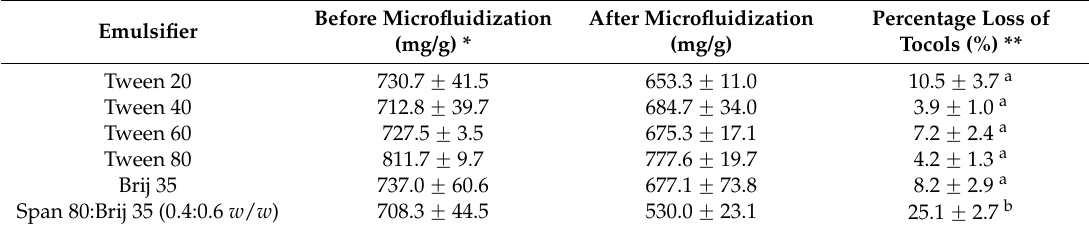
Concentration of tocols in TRF nanoemulsion prepared with different emulsifiers (mean ˘ S.D., n =